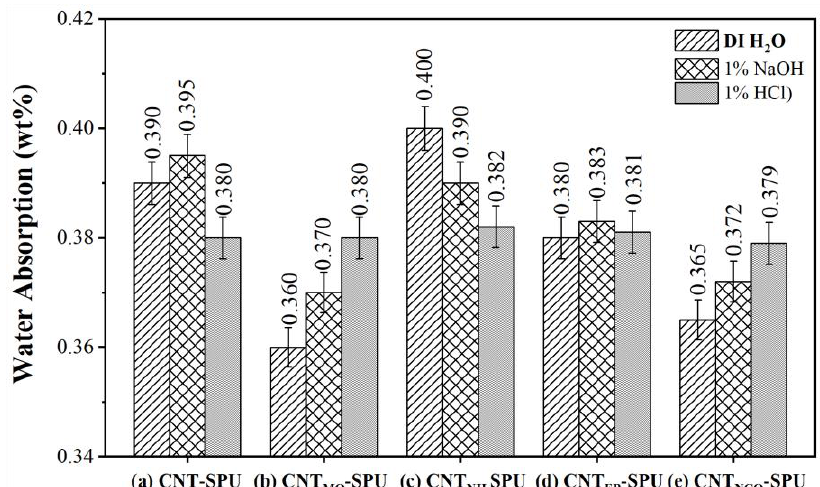
Figure 8. Water resistance of composite free-standing film before and after modification: ( a ) CNT-